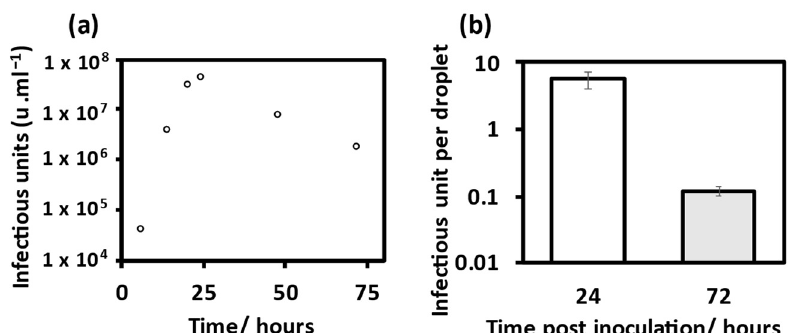
Figure 1. Propagation and TCID 50 of mouse hepatitis virus (MHV). ( a ) Infectious titre of stock solution retrieved from 17-CL1 cells post inoculation with MHV after incubation period, calculated using TCID 50 . ( b ) Mean infectious unit per droplet for two virus titres from MHV propagation. 24 h inoculation (M = 5.59, SD = 1.57), compared with 72 h inoculation (M = 0.11, SD = 0.017), error bars show standard deviation.